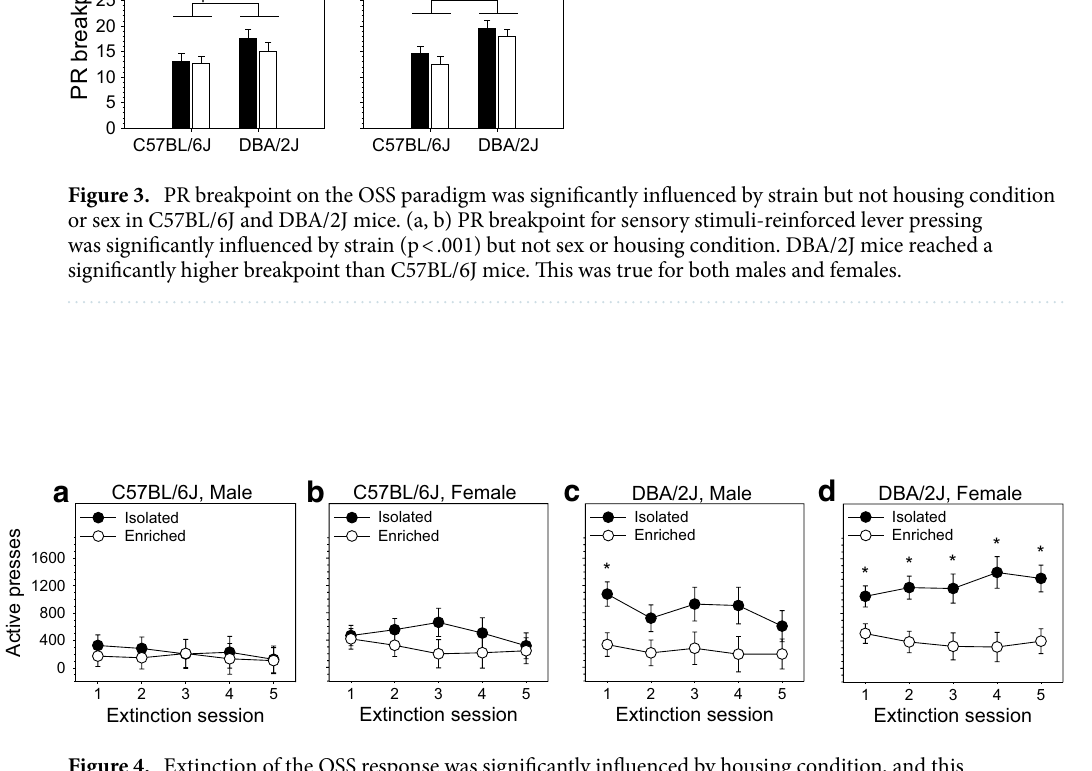
Figure 4. Extinction of the OSS response was significantly influenced by housing condition, and this relationship was significantly dependent on strain and sex. ( a , b ) There was no observed effect of housing on extinction responding in C57BL/6J mice, and this was true in both males and females. ( c , d ) In contrast, there was a robust and statistically significant effect of housing condition in DBA/2J mice: isolation housed male and female DBA/2J mice produced significantly more active but not inactive lever presses on the first extinction session relative to their environmentally enriched littermates. In female but not male DBA/2J mice, the number of active lever presses produced by isolation housed mice was significantly greater than the number produced by environmentally enriched mice throughout the remainder of the extinction